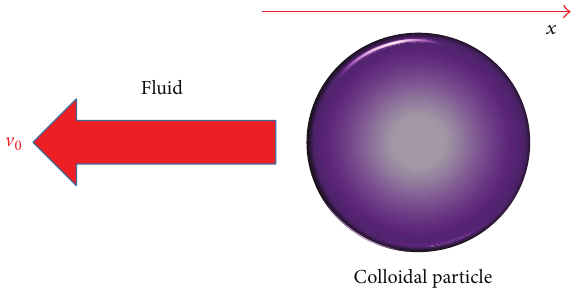
Figure 6: Colloidal particle of radius 𝑎 immersed in a fluid, which moves in the 𝑥 -direction at a constant speed V 𝑜 .